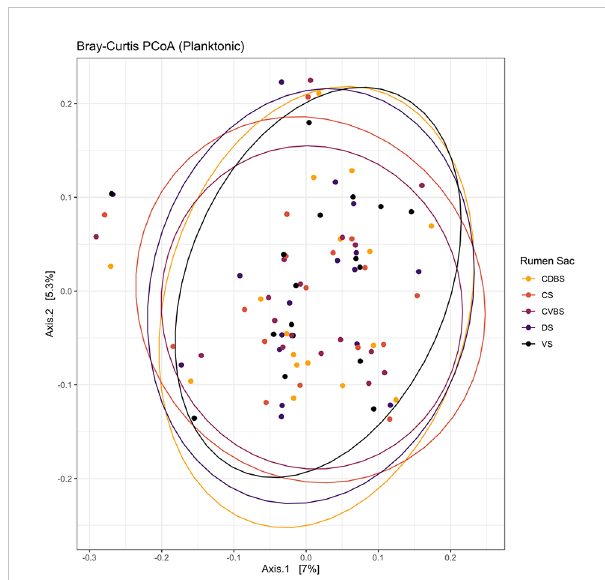
FIGURE 8 Bray-Curtis principal coordinates analysis of the planktonic fraction among the fi ve rumen sacs. Beta-diversity was measured with the Bray-Curtis distances and visualized through a principal coordinates analysis (PCoA). The CDBS is shown in the orange circles, CS is shown in red circles, CVBS is shown in light purple circles, DS is shown in dark purple circles, and VS is shown in black circles. The circles represent a 95% con fi dence interval around the means of the planktonic bacterial communities within each rumen sac. No signi fi cant distance measurement was found (P >